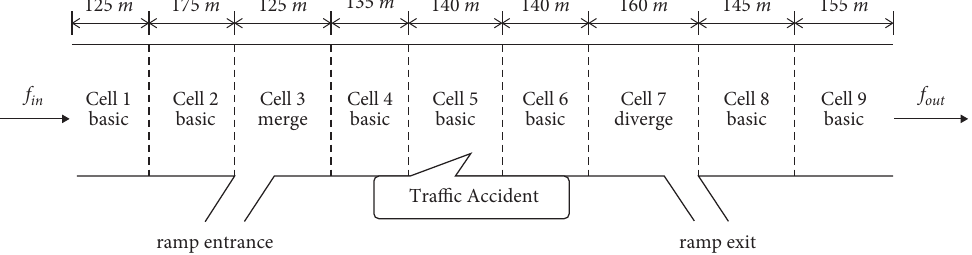
Figure 15: The simulation segment of mixed traffic